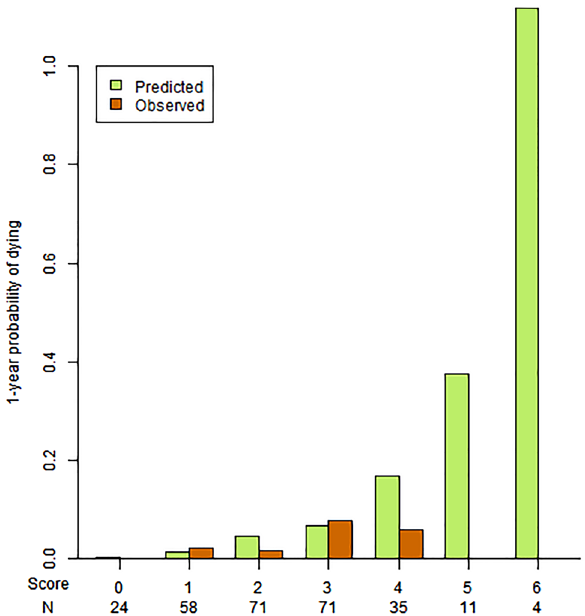
Figure 5. Calibration of the score in the validation sample, for the mortality risk at 1